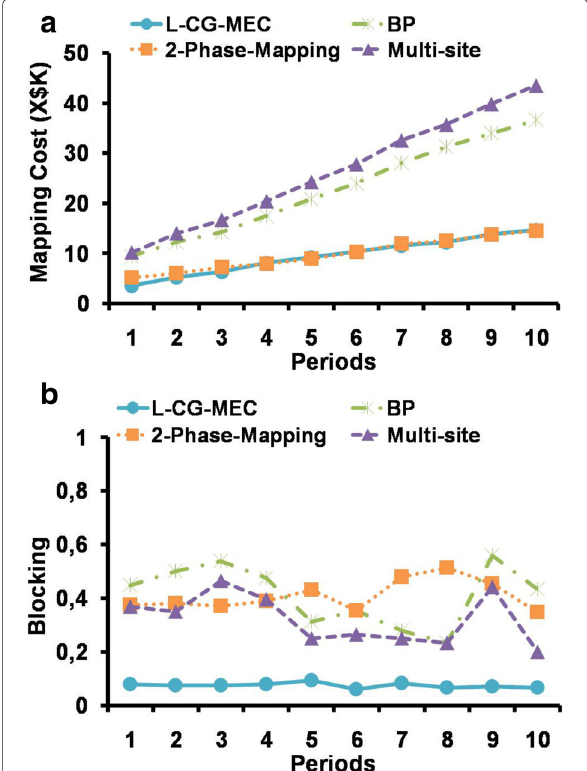
Fig. 4 Performances L-CG-MEC vs. benchmarks. a Mapping cost. b Blocking